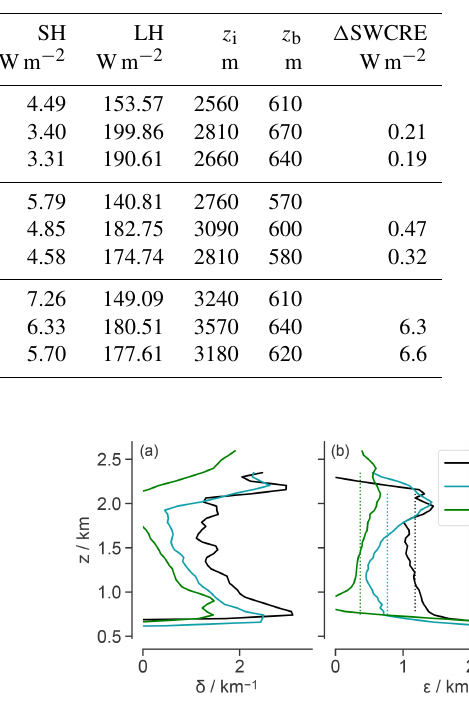
Figure 5. (a) Fractional entrainment ( ε ) and (b) detrainment rate ( δ ) at 100m, 500m and 5km resolution in CTL. The mean entrainment rate in the cloud layer is shown as dotted